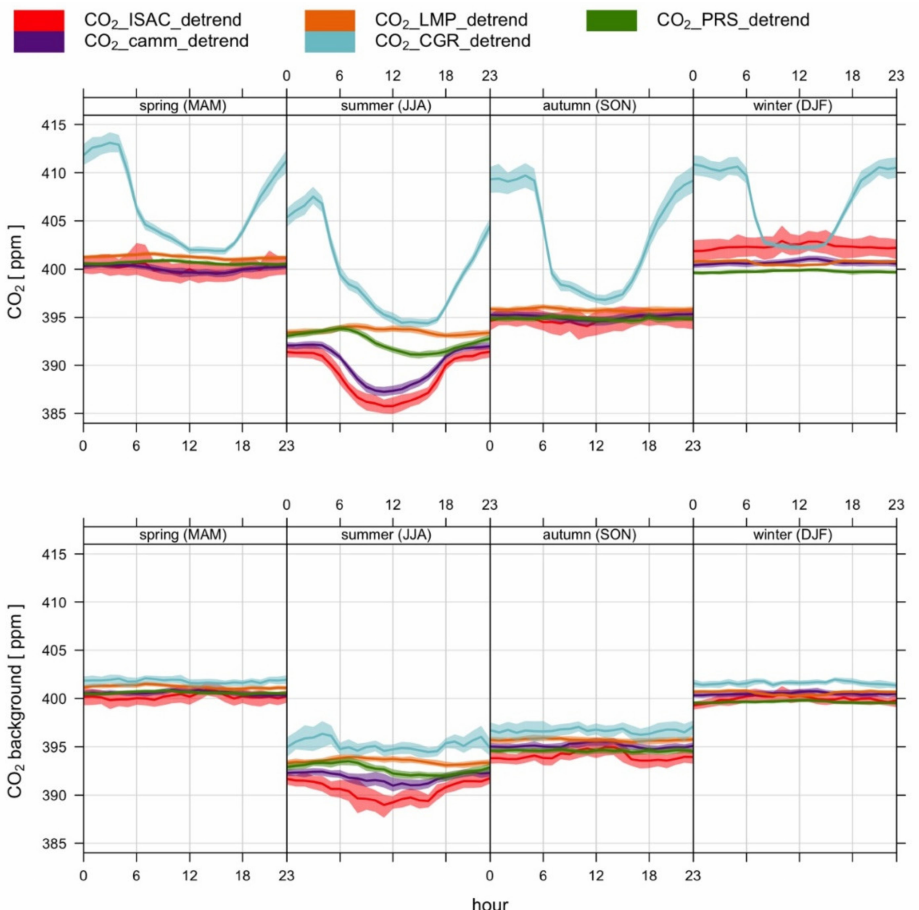
Figure 3. Top: seasonal average diurnal variations of the unselected detrended CO 2 data. Bottom: same as above, for the background datasets. The shaded areas denote the 95% confidence level calculated through bootstrap simulations (see Carslaw et al.